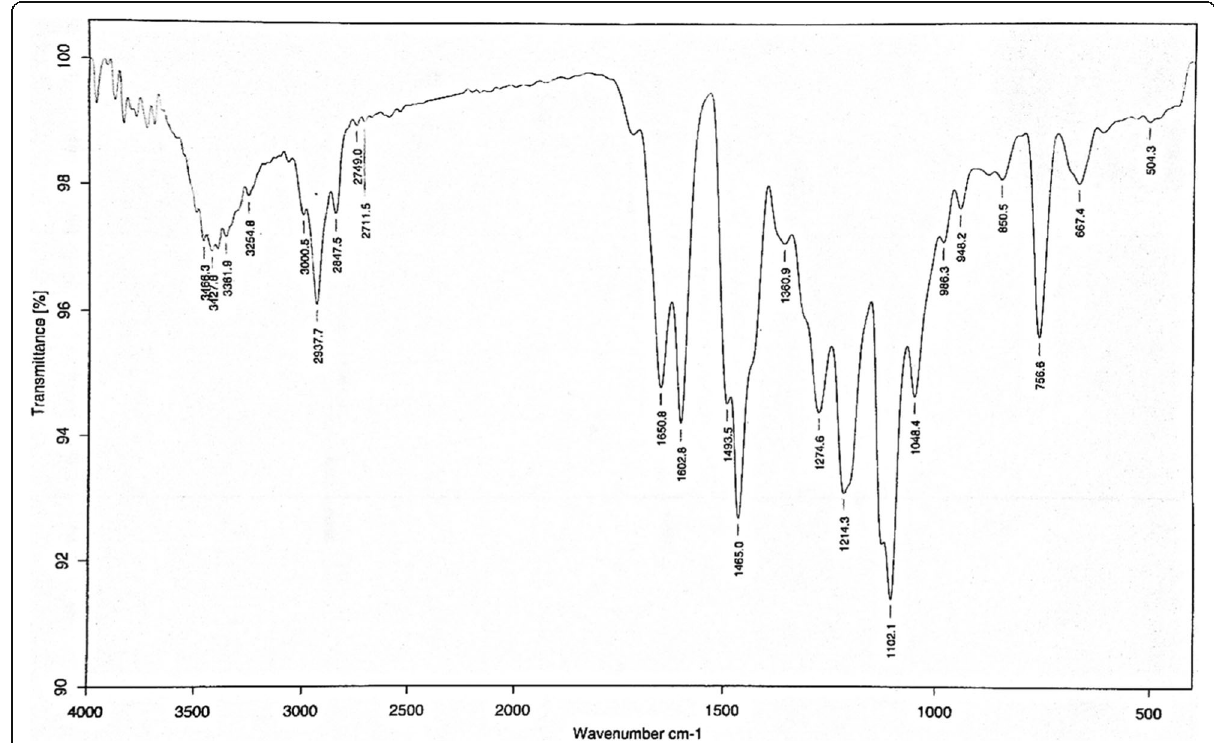
Fig. 1 Chromatogram of FTIR of A. precatorius . Resolution 2 cm − 1 (10 scans). Intense peaks around 1500-3450cm − 1 indicating the presence of flavonoids, isoflavonoids, carbonyl groups, and hydroxyl